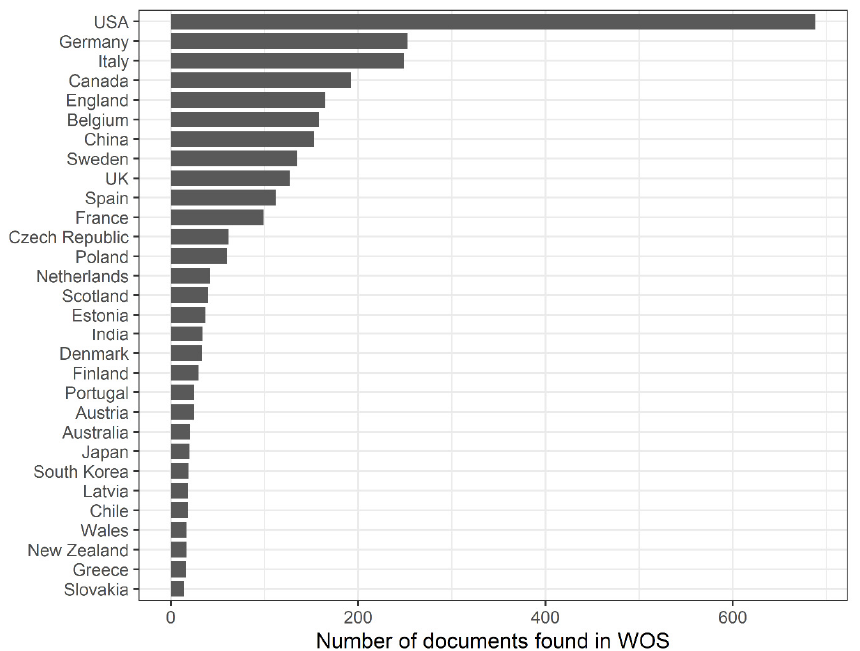
Figure 3. Ranking of the number of publications per country (including only the top 30 countries) found in the Web of Science (WOS) journal database, for the combination of the terms Populus or poplar, and short rotation or energy crop, in July 2020.